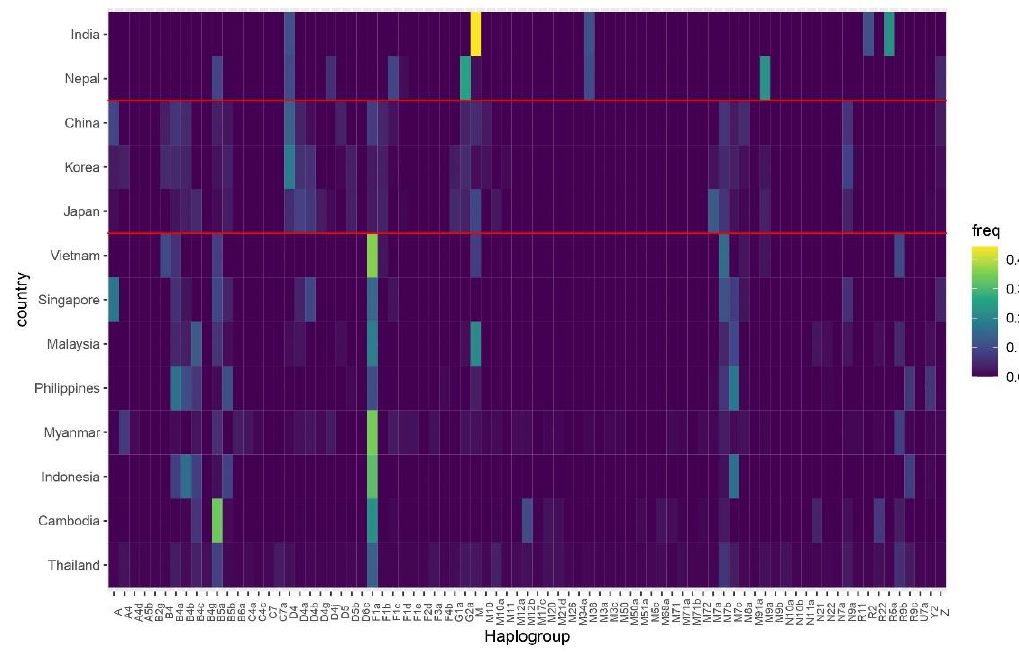
Figure 4. Heatmap of haplogroup frequencies of some Asian populations based on SNP data. The first two PCAs of the haplogroup frequencies accounted for 55.3% of the variation and show that Southeast Asian populations appear more similar to each other than to countries from the other regions (Figure 5).